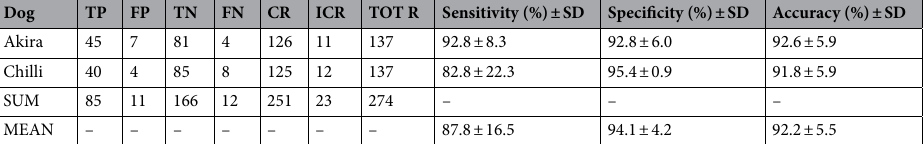
Table 2. Mean results presented as sensitivity, specificity and accuracy in percent, including ± standard deviation (SD), calculated from 21 randomized and double-blind experimental searches carried out on trees and untreated wooden pallets in a semi-field condition between 11 to 20th of May 2020 at the University of Southeast Norway including both invasive and native wood borers. A dog`s response to a scent sample could be either; TP true positive response, FP false positive response, TN true negative response and FN false negative response. CR total number of correct responses, ICR total number of incorrect responses, and TOT R total number of responses.